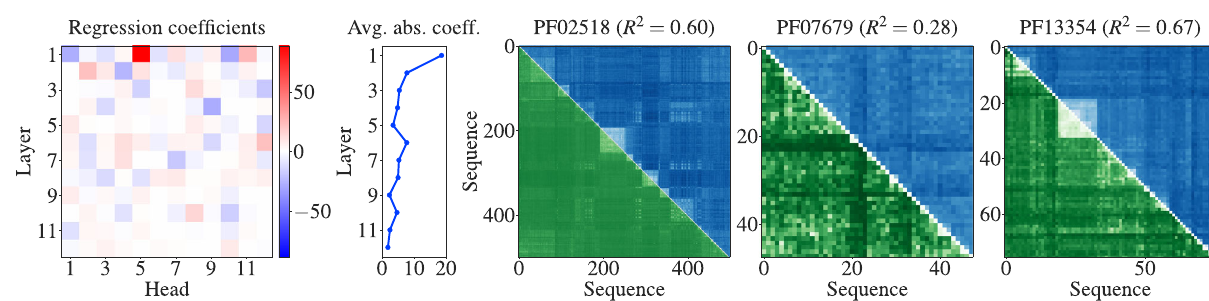
asinFig.2.ForthethreetestMSAs,groundtruthHammingdistancesareshownin the upper triangle (blue) and predicted Hamming distances in the lower